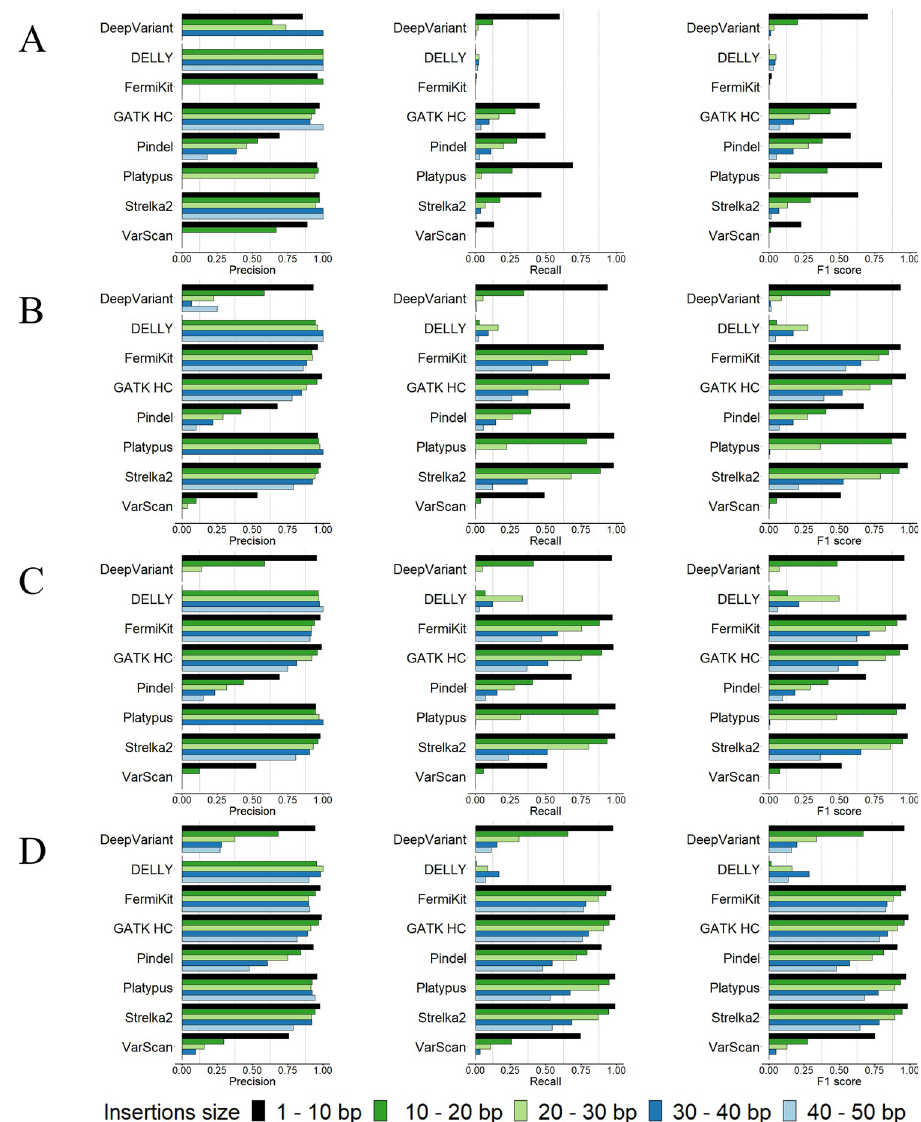
Fig 4. Precision rates, recall rates and F1 scores of the tools for calling insertions < 50bp using the semi-simulated datasets. (A) 5 × coverage, 100bp read length sequencing data. (B) 30 × coverage, 100bp read length sequencing